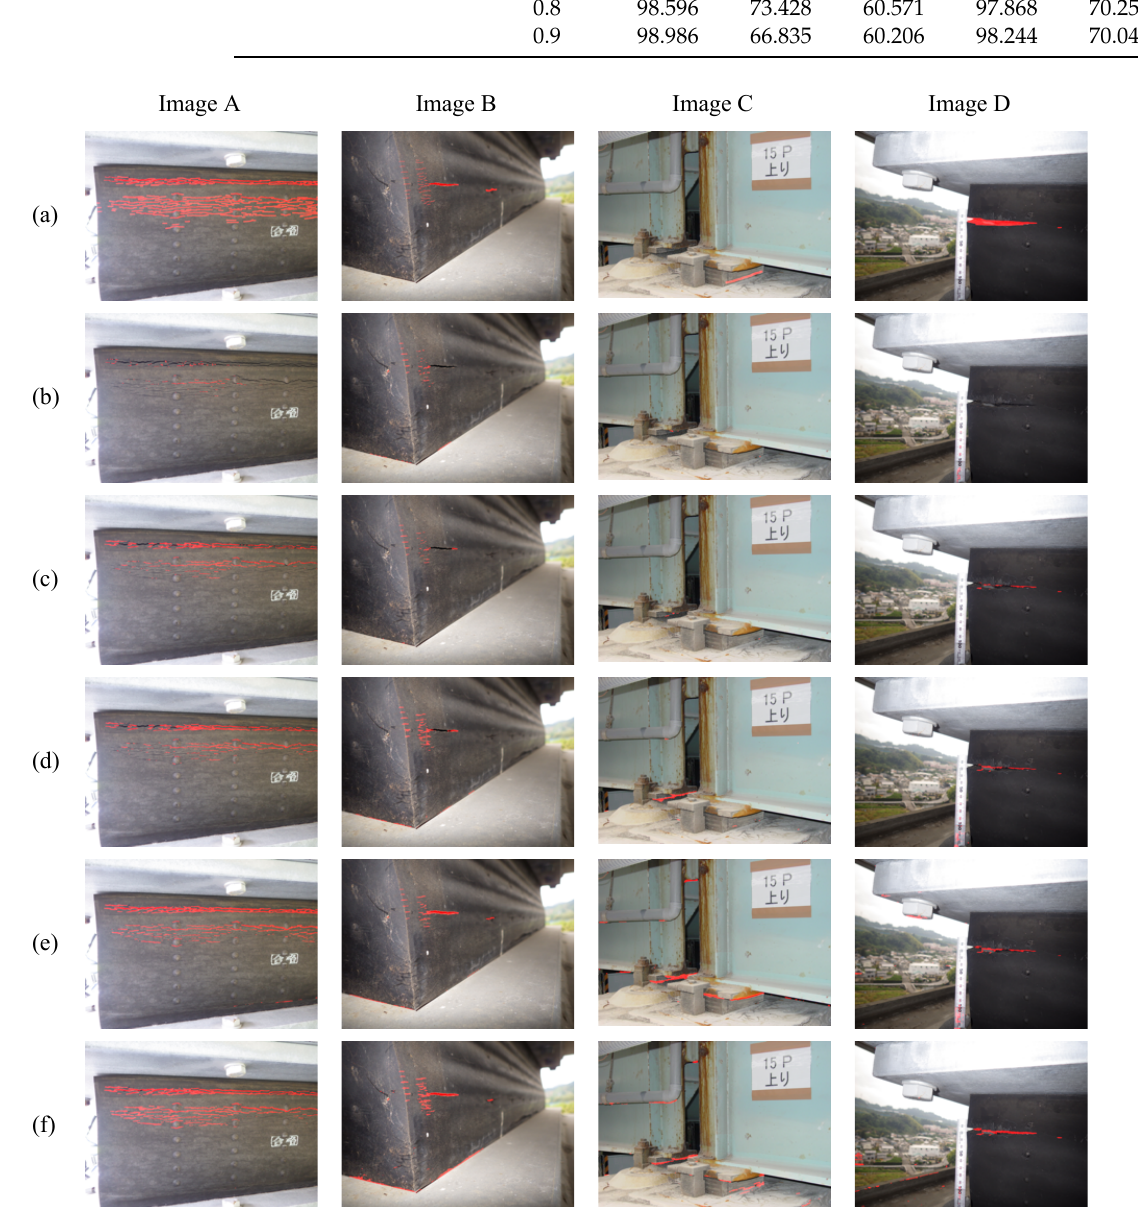
Fig.11 Examples of prediction results: (a) ground truth, (b) no data drop results, Figure 12. Examples of prediction results: ( a ) ground truth, ( b ) no data drop results, ( c ) BDDR of 0.2, ( d ) BDDR of (c) BDDR of 0.2, (d) BDDR of 0.5, (e) BDDR of 0.8, (f) BDDR of 0.9